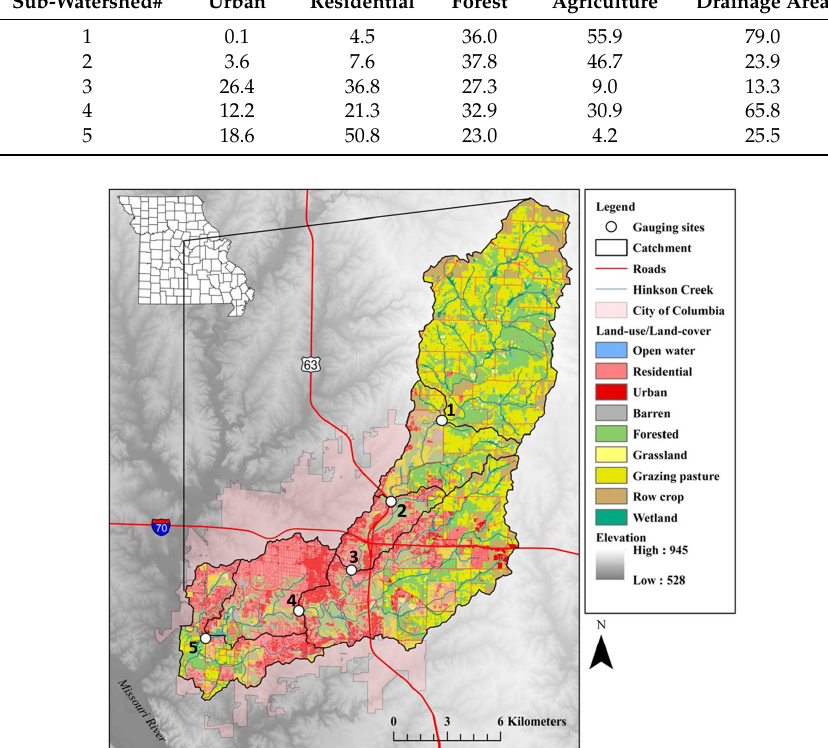
Figure 1. Nested-scale experimental watershed study design including five gauging sites/sub- watersheds in Hinkson Creek Watershed, MO, USA (Map by Sean Zeiger).